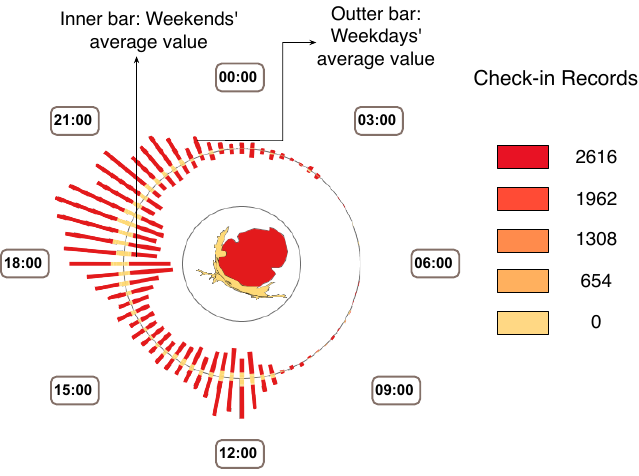
Figure 2. Activity-based Fingerprint on Social Check-in Behaviors. The geometric shapes inside the icon encode selected regions of a city. Here we applied the WorldMapper technique to use space distortion to encode the number of check-ins in that region, while the color represents the density as shown in the right part. The outer bar presents the average weekday value, while the inner bar shows the average weekend value. Each bar is formed by a set of slices of different lengths. One slice on the bar represents one region and its length shows the related number of